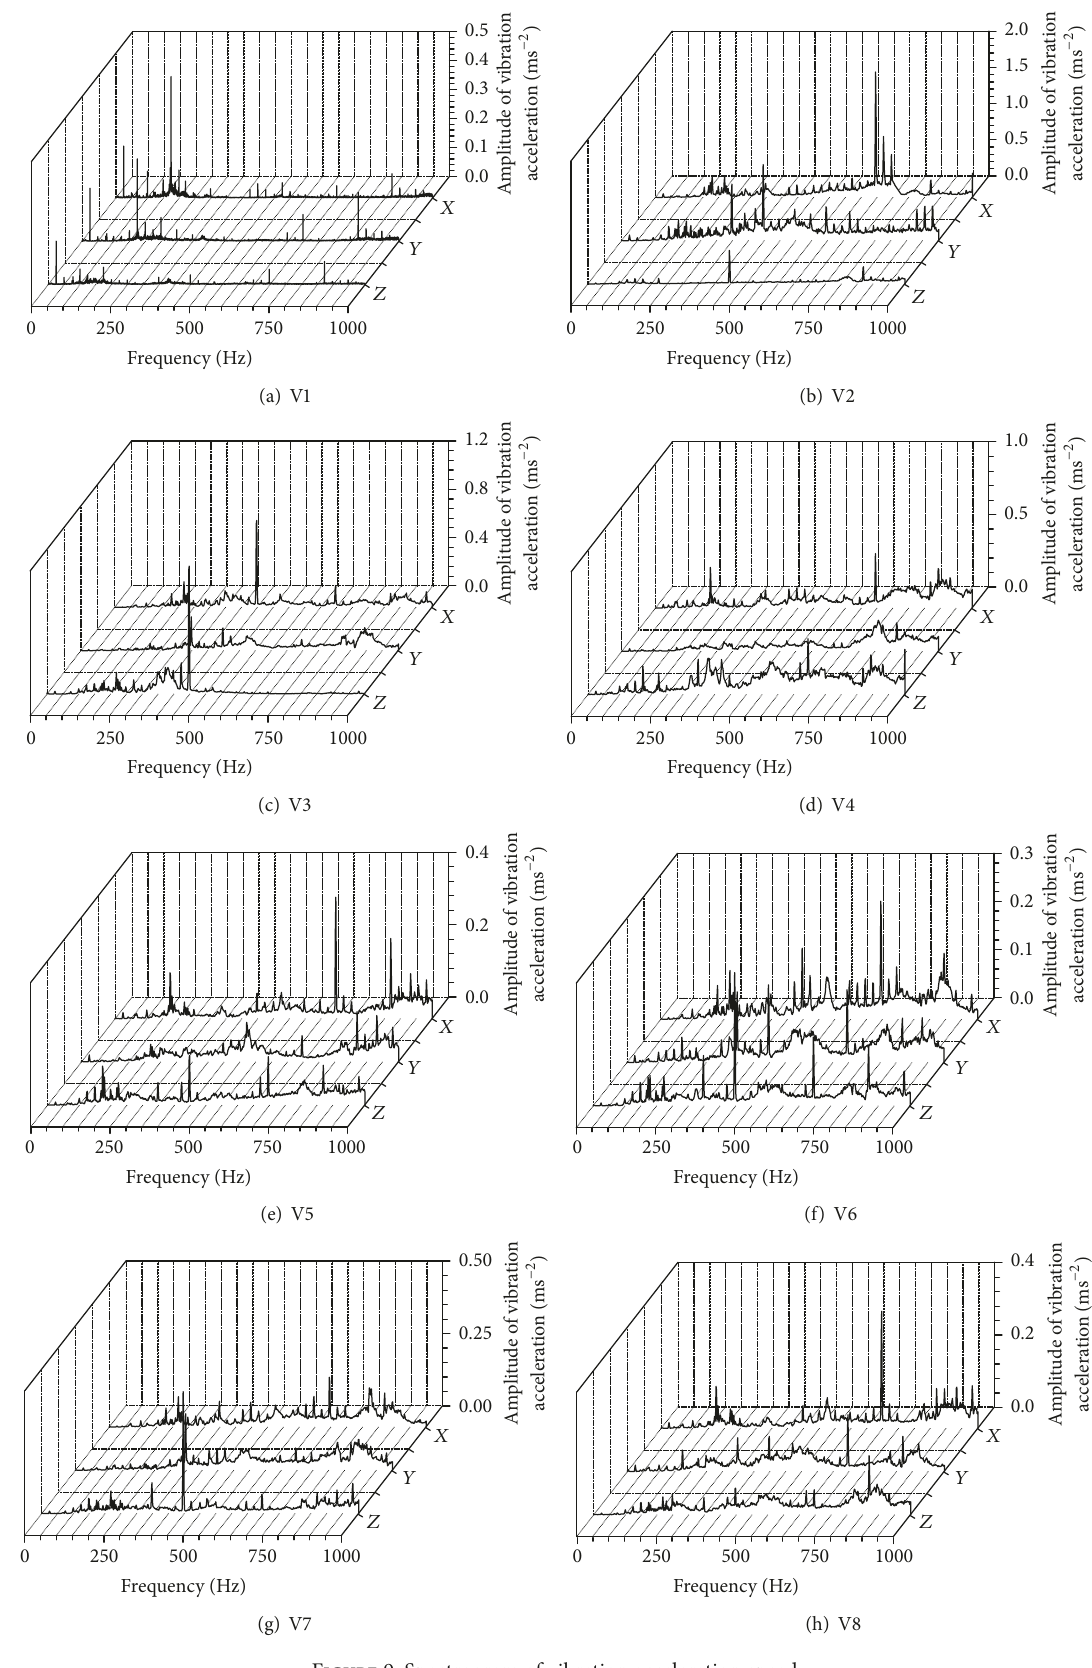
Figure 9: Spectrogram of vibration acceleration